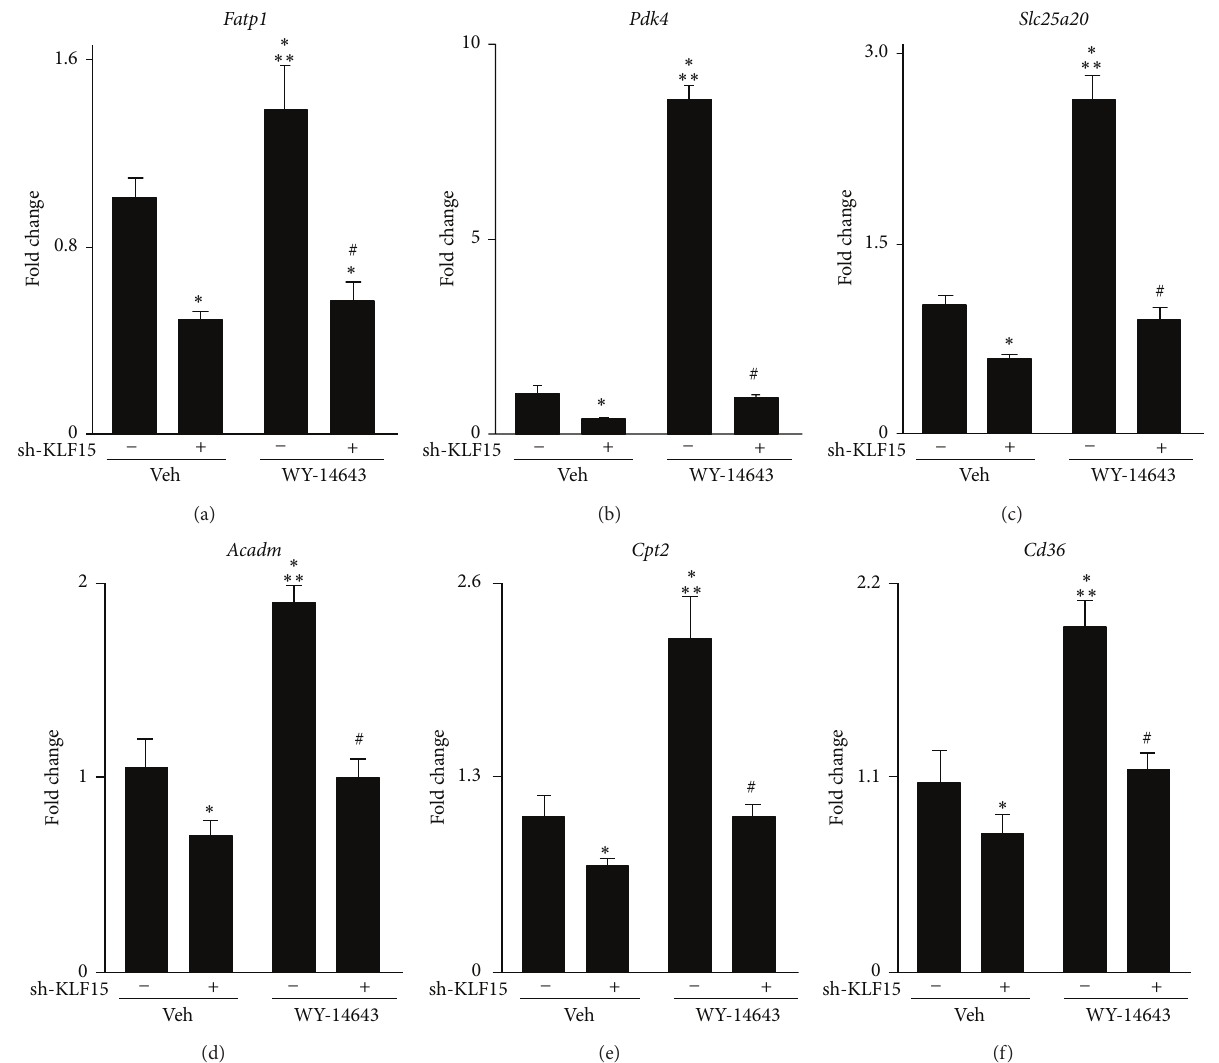
Figure 4: Ligand induced PPAR 𝛼 gene targets are KLF15 dependent. Fatp1 (a), Pdk4 (b), Slc25a20 (c), Acadm (d), Cpt2 (e), and Cd36 (f) expression(qPCR)inneonatalratventricularcardiomyocytesaftersh-RNAmediated Klf15 silencingintheabsenceorpresenceofthePPAR 𝛼 - specific ligand WY-14,643 (10 𝜇 M, 24 hrs). ( 𝑛 = 6 ). ∗ 𝑃 < 0.05 versus vehicle. ∗∗ 𝑃 < 0.05 versus sh-KLF15. # 𝑃 < 0.05 versus WY-14643. Values normalized to Ppib